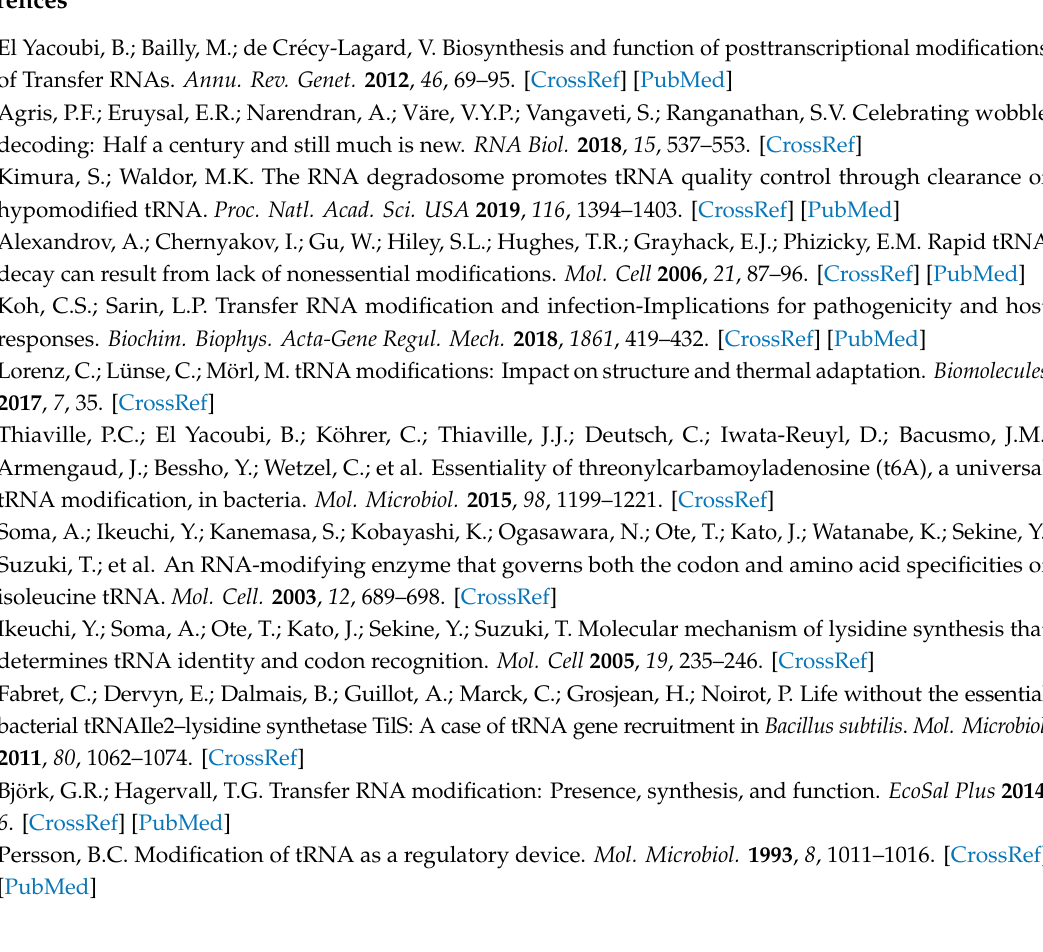
Table S1: Validated E. coli tRNA modification genes, Table S2: Predicted and validated B. subtilis modification genes, Table S3: Summary of B. subtilis tRNA modification mapping by RiboMethSeq and PsiSeq, Table S4: Fitness data for tRNA modification genes in B. subtilis , Table S5: Expression data tRNA modification genes in B. subtilis , Figure S1: Mapping of tRNA and rRNA modification by RiboMethSeq and derived RT-signatures, Figure S2: Tandem mass spectrum of di ff erent tRNAs at di ff erent positions, Figure S3: Bar plots for normalized PsiScore values for six B. subtilis tRNAs containing ψ 31 and ψ 32 residues, Figure S4: Relative ion abundances of tRNA modifications found in B. subtilis